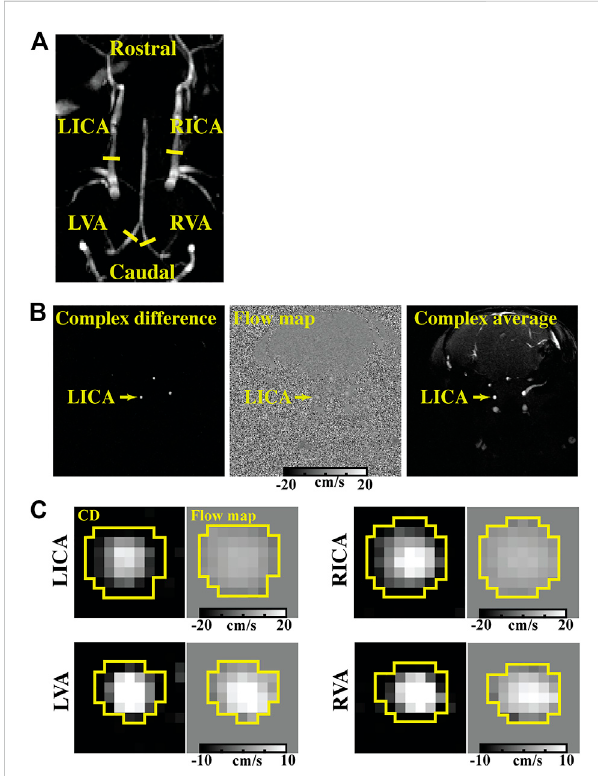
Representative dataset of PC MRI. (A) shows the TOF image displaying the slice locations of PC MRI (yellow solid lines perpendicular to the vessel trajectory) focusing on different arteries (LICA, RICA, LVA, and RVA). (B) shows the complex difference (CD), fl owmap,andcomplexaverageimagesofaPCscanfocusingon the LICA. (C) presents the CD images and fl ow maps of four feeding arteries. ROIs for quantifying blood fl ow were delineated on the CD images (yellow boxes) and then applied to the fl ow